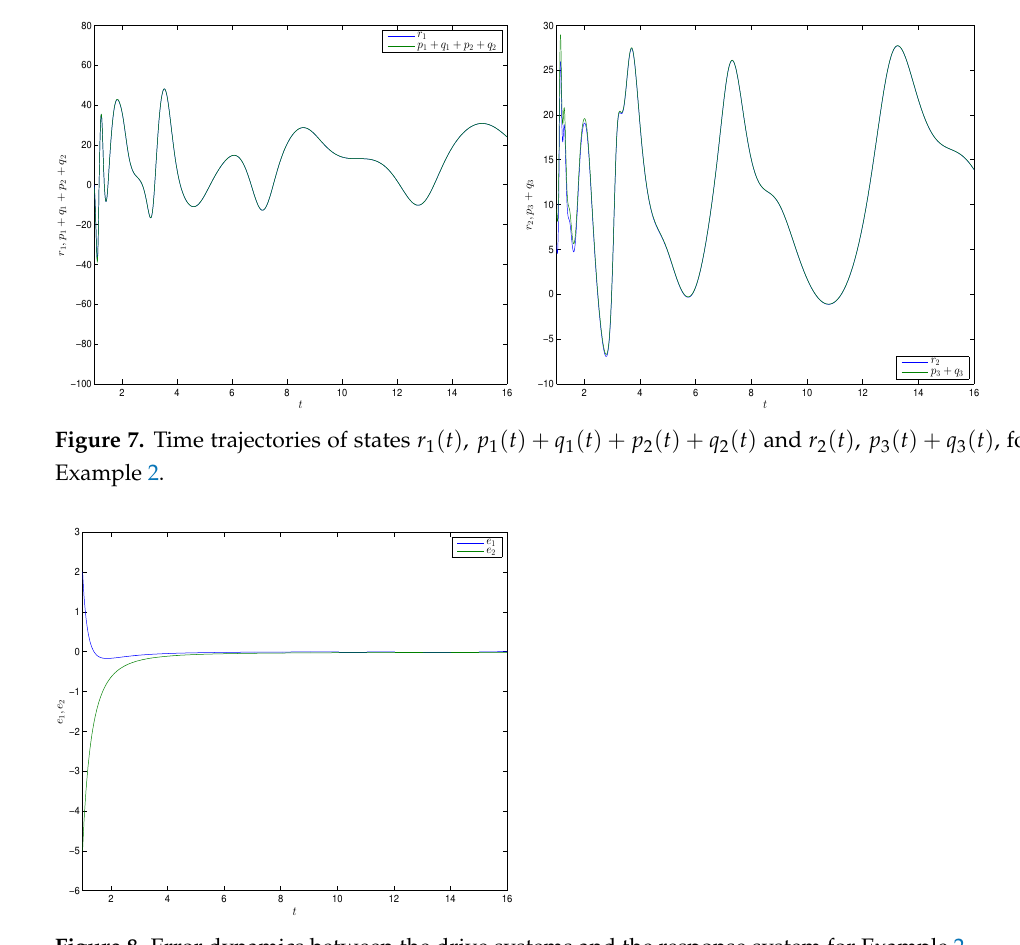
Figure 8. Error dynamics between the drive systems and the response system for Example